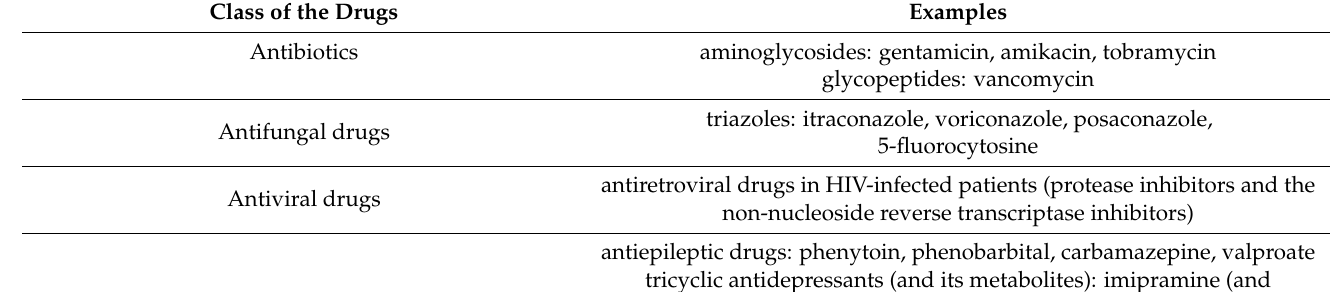
Table 2. The examples of drugs subjected to the TDM procedure [31,55,58–67]. Class of the